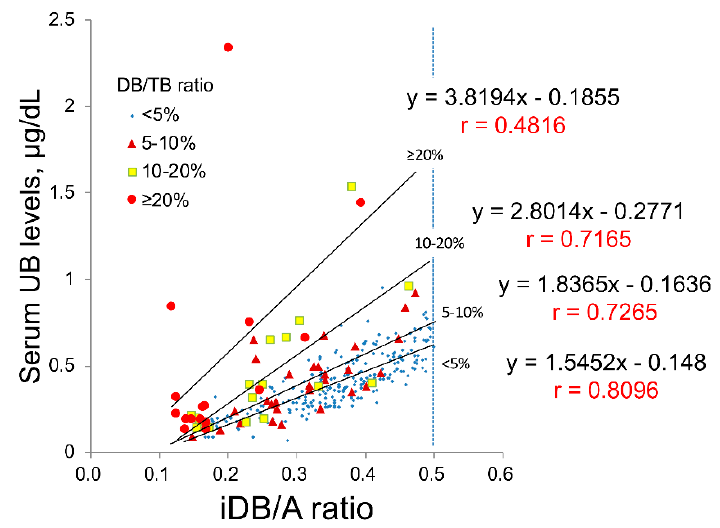
Figure 1. Correlations between the iDB/A ratio and UB classified by DB/TB ratio in clinical serum samples. The 301 serum samples were classified into four groups according to the DB/TB ratio for < 5%, n = 239; 5–10%, n = 29; 10–20%, n = 17; and ≥ 20%, n = 16. A, albumin; DB, direct bilirubin; iDB, indirect